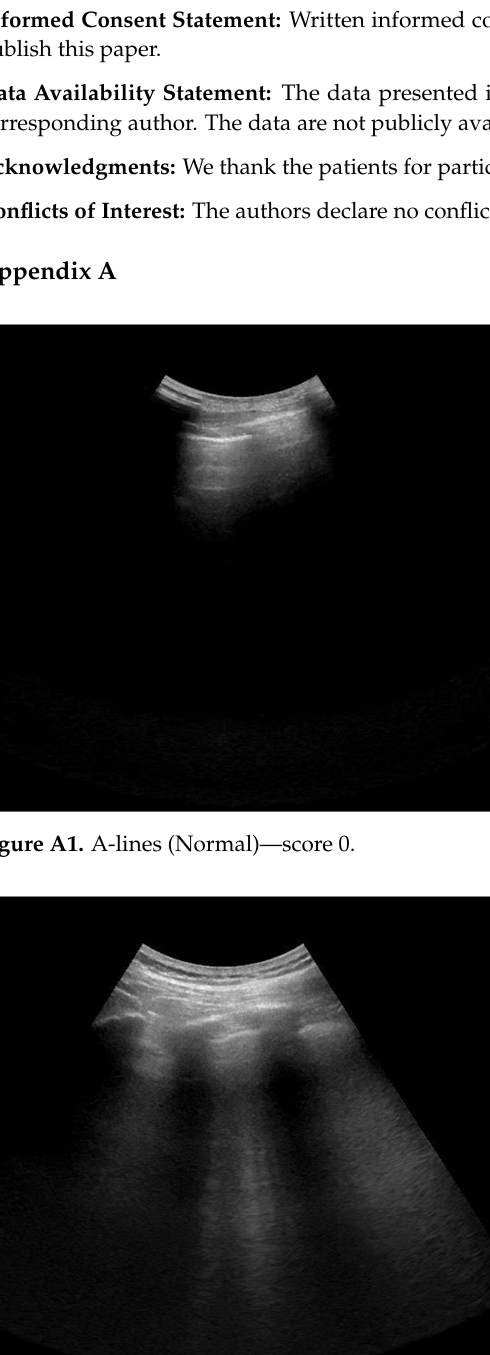
Figure A3. Coalescent B-lines (B2)—score 2.